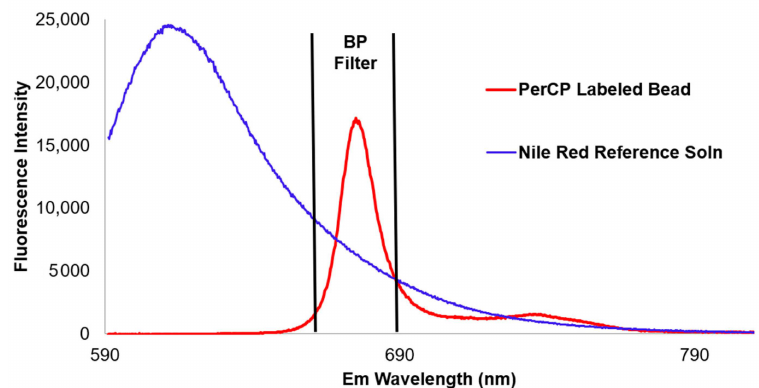
Figure 2. Fluorescence spectra of a reference fluorophore (Nile Red) and a calibration bead (PerCP labeled) and the bandpass (BP) filter spectral region over which the intensities were integrated for an ERF assignment.